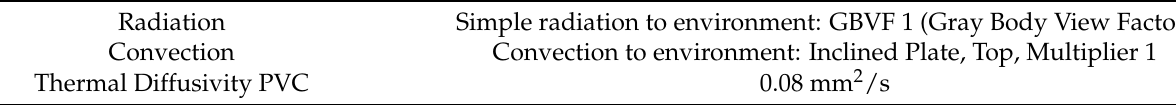
Table 1. Settings used in finite element